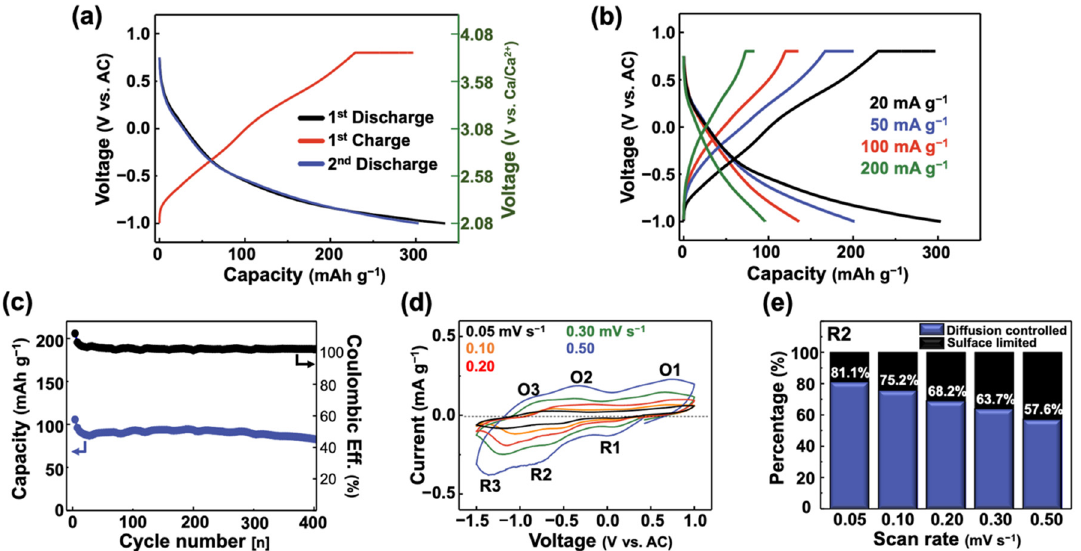
Figure 2. ( a ) The initial galvanostatic discharge/charge curves at a current density of 20 mA g − 1 , ( b ) second discharge/charge curves at various currents, ( c ) cycle performance at 200 mA g − 1 , ( d ) cyclic voltammograms for the first cycle at various scan rates, ( e ) ratio of contribution of the diffusion-controlled intercalation and surface-limited capacitive reaction.